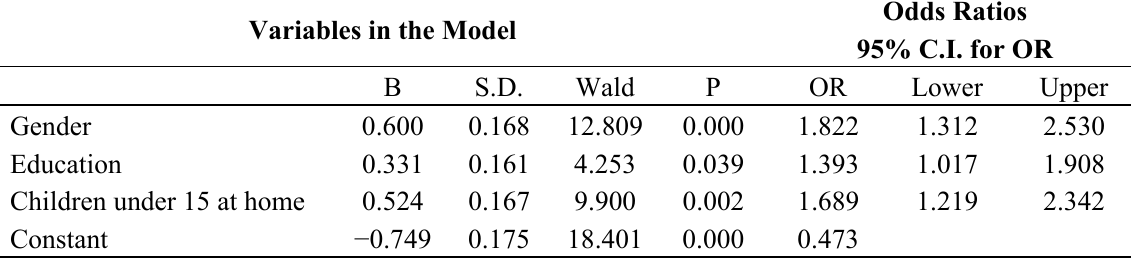
Table 3. Logistic regression: factors that determine workplace bullying